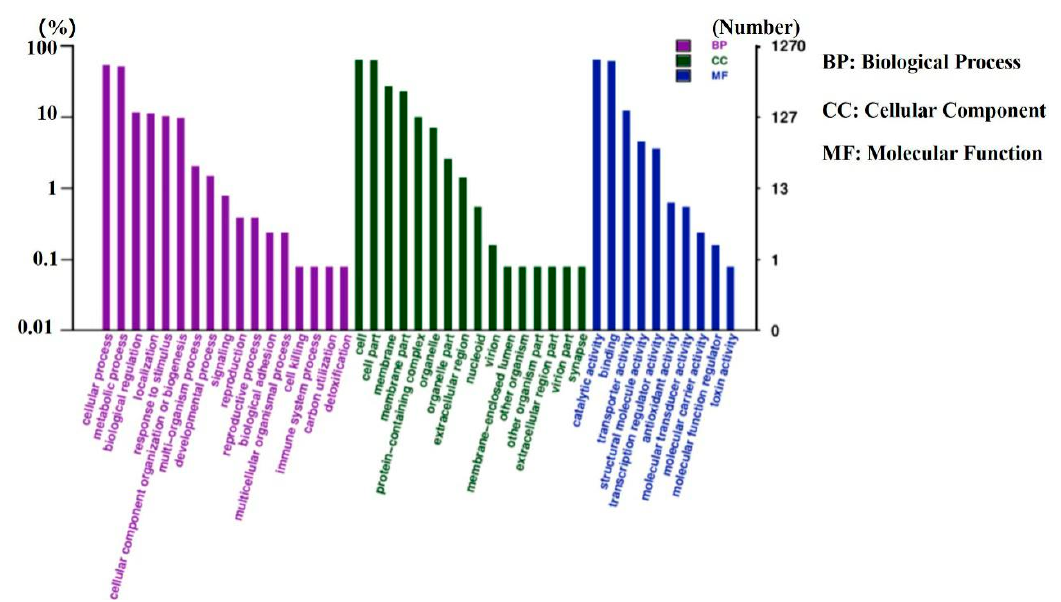
Figure 5. The GO annotation of the L. sakei genome .